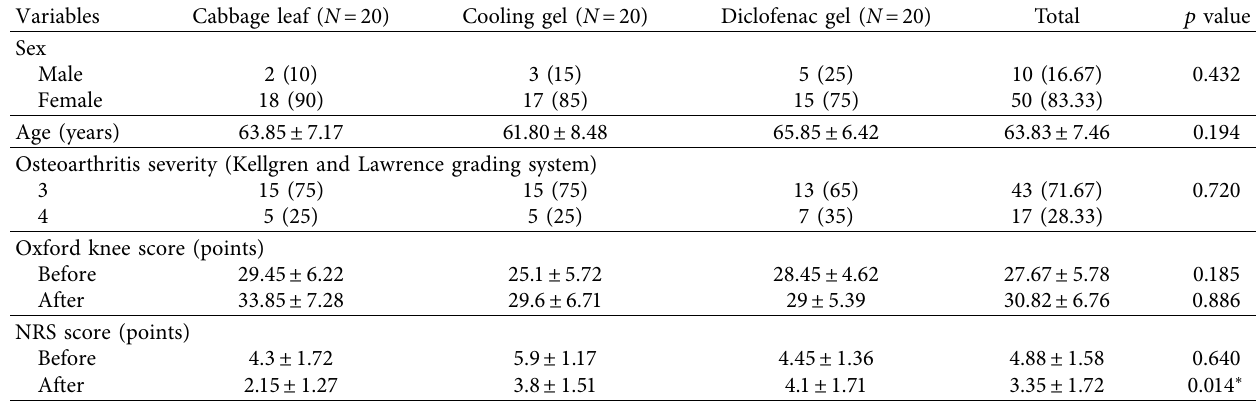
Table 1: General baseline characteristics of patients with